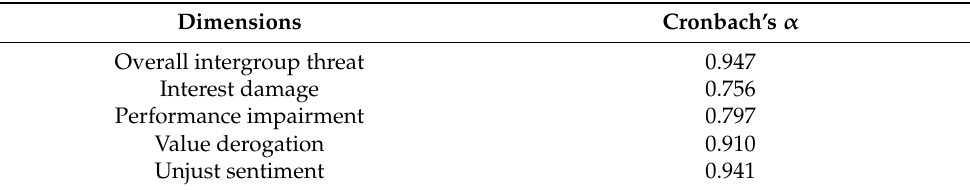
Table 3. Coefficients of internal consistency.